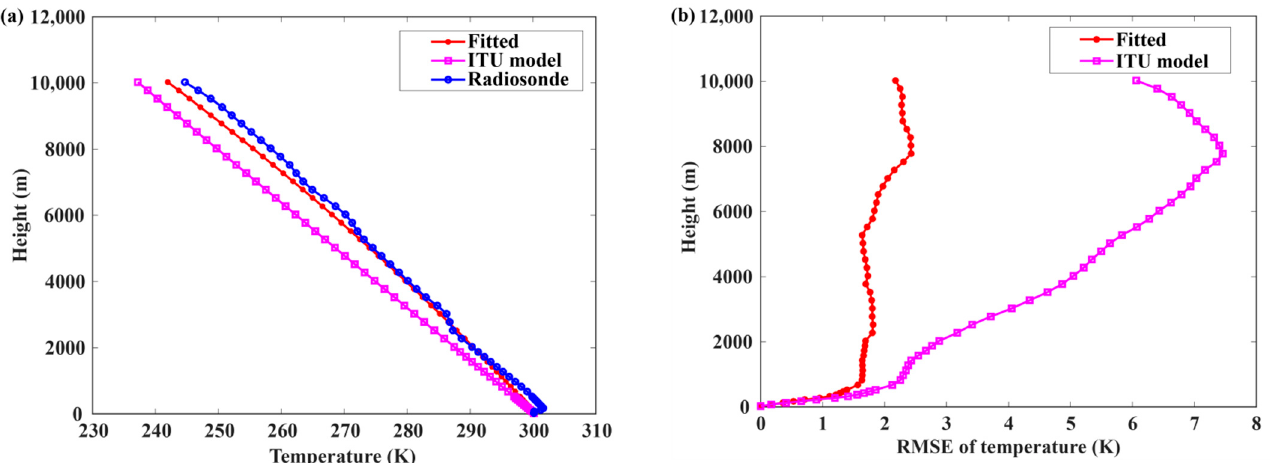
Figure 7. ( a ) The comparison between fitted, ITU model, and radiosonde temperature profile; ( b ) The root mean square error of fitted and ITU model temperature profile.